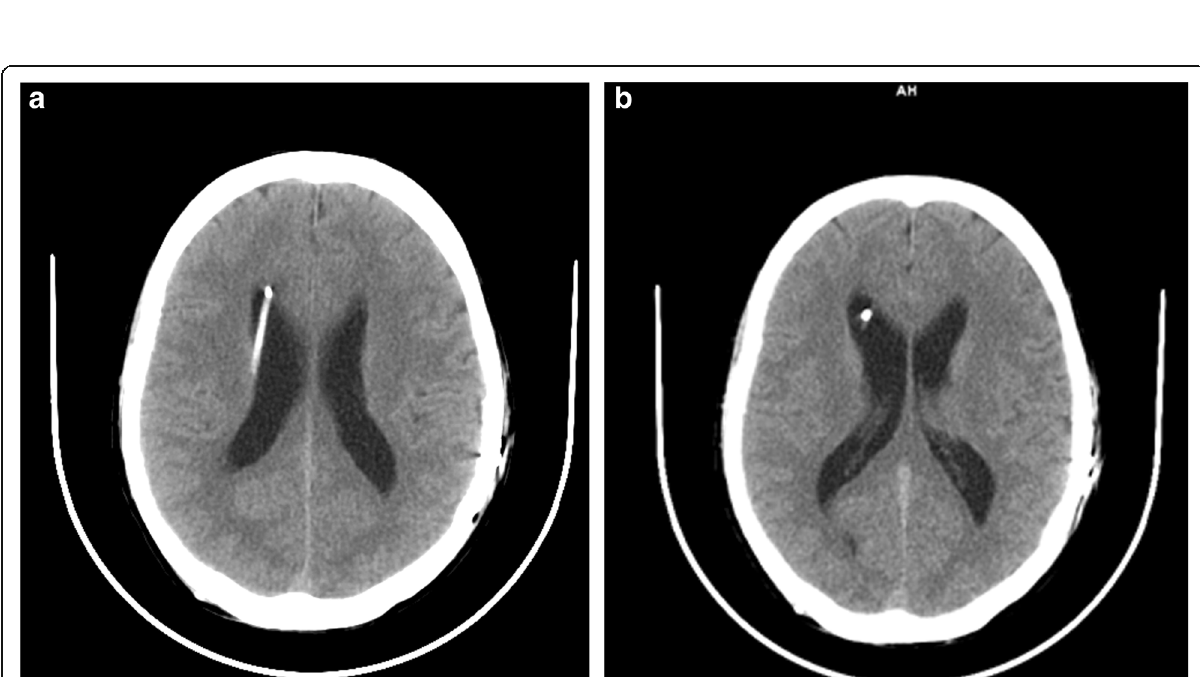
Fig. 3 a CT image showing the catheter tip traversing towards the tip of the frontal horn. b A more caudal image showing the tip of the catheter in the anterior part of the frontal